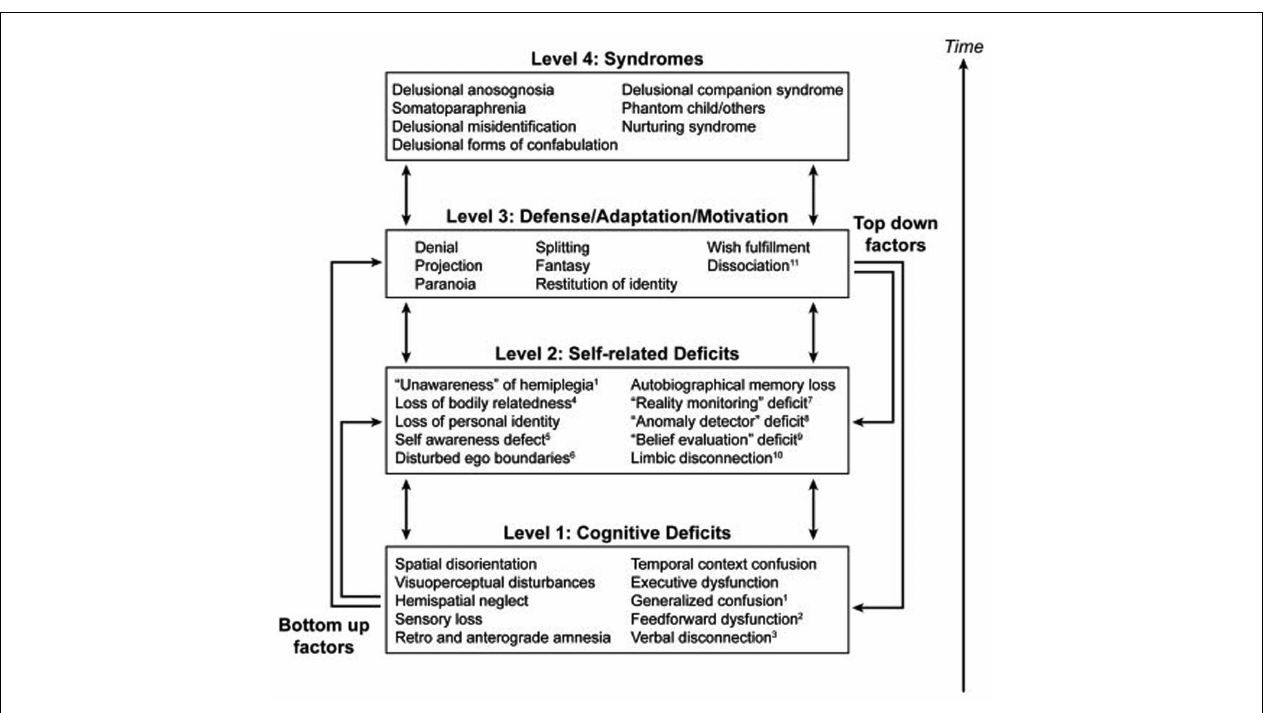
FIGURE 3 |A hierarchical four-tiered model of representative factors contributing to the neuropathologies of the self. Specific cognitive deficits may only be relevant to certain conditions, while self-related deficits and positive features may be applied to all syndromes (Feinberg, 2011). Image courtesy of